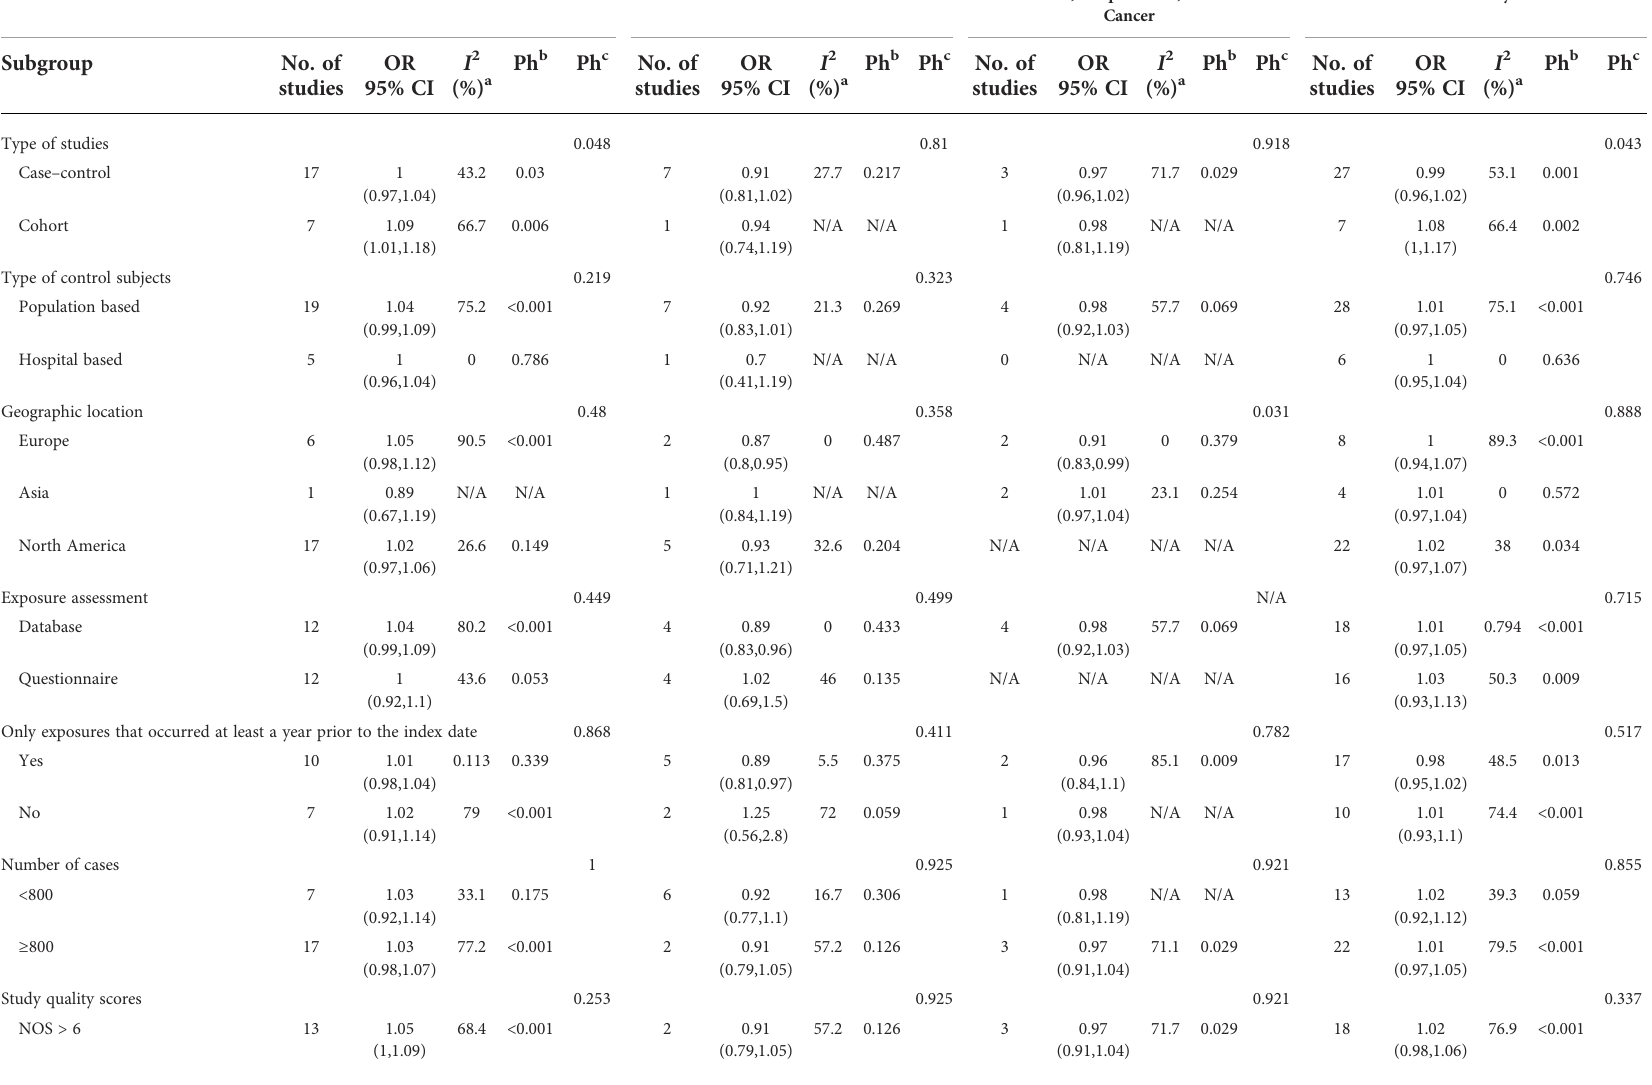
TABLE 2 Subgroup analyses of the study characteristics and confounders. Breast